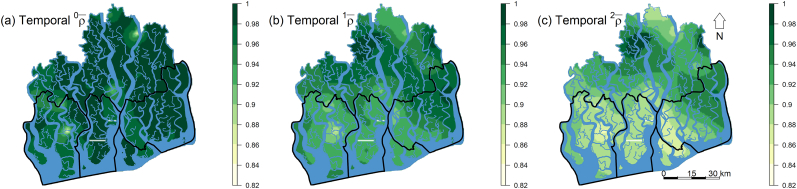
Spatial maps showing the distributions of temporal change in subcommunity representativeness (i.e. ρ¯ at q = 0, 1, and 2) during 1986–2014 generated through ordinary kriging. Low representativeness indicates a high temporal turnover (or heterogeneity) in species composition while high representativeness suggests stable species composition over time. The black contours represent the three protected areas.